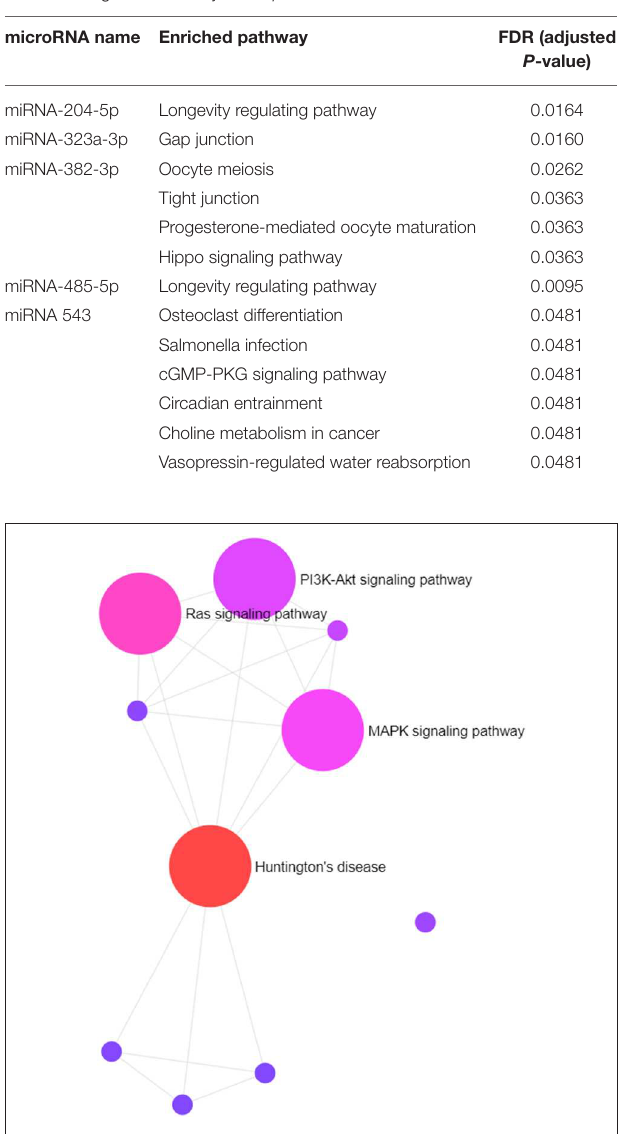
FIGURE 5 | Visual representation of primary pathways targeted by miR-210. The size of the circles correlates roughly with the proportion of genes that are involved in a particular